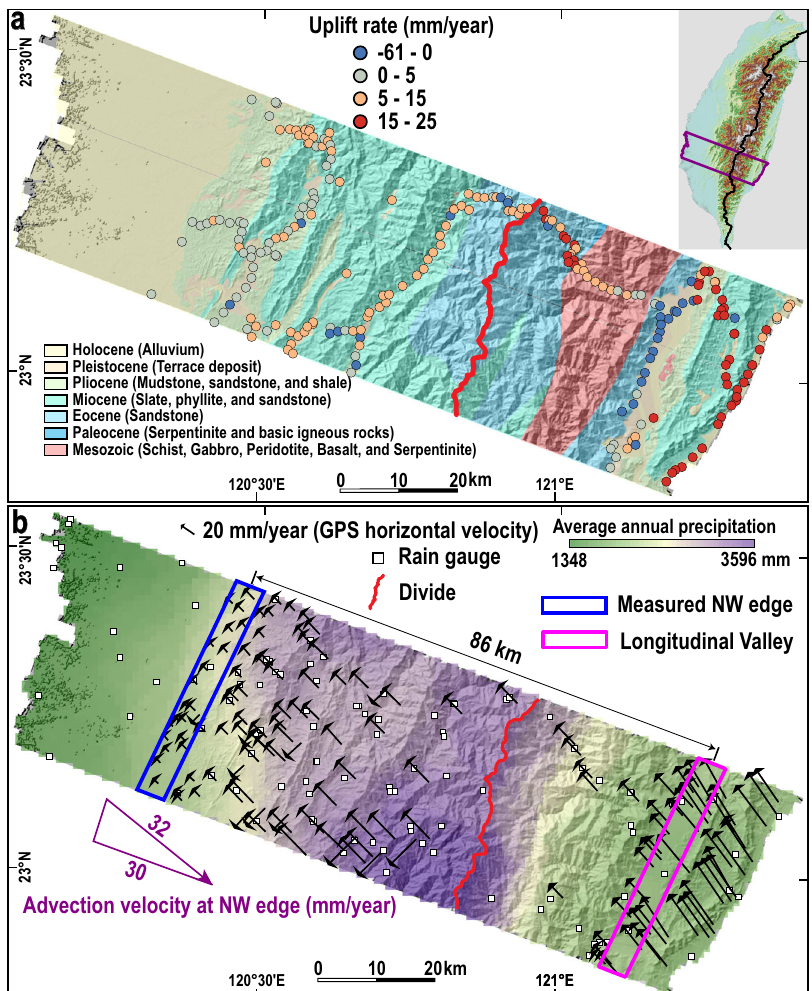
Fig. 6 Natural example of Southern Taiwan. a GPS-derived uplift rates (2002 – 2013) and lithology of Southern Taiwan. b GPS horizontal velocities in a fi xed Eurasia frame and average annual precipitation of Southern Taiwan (1990 – 2010). See “ Methods ” for the details on the estimation of advection